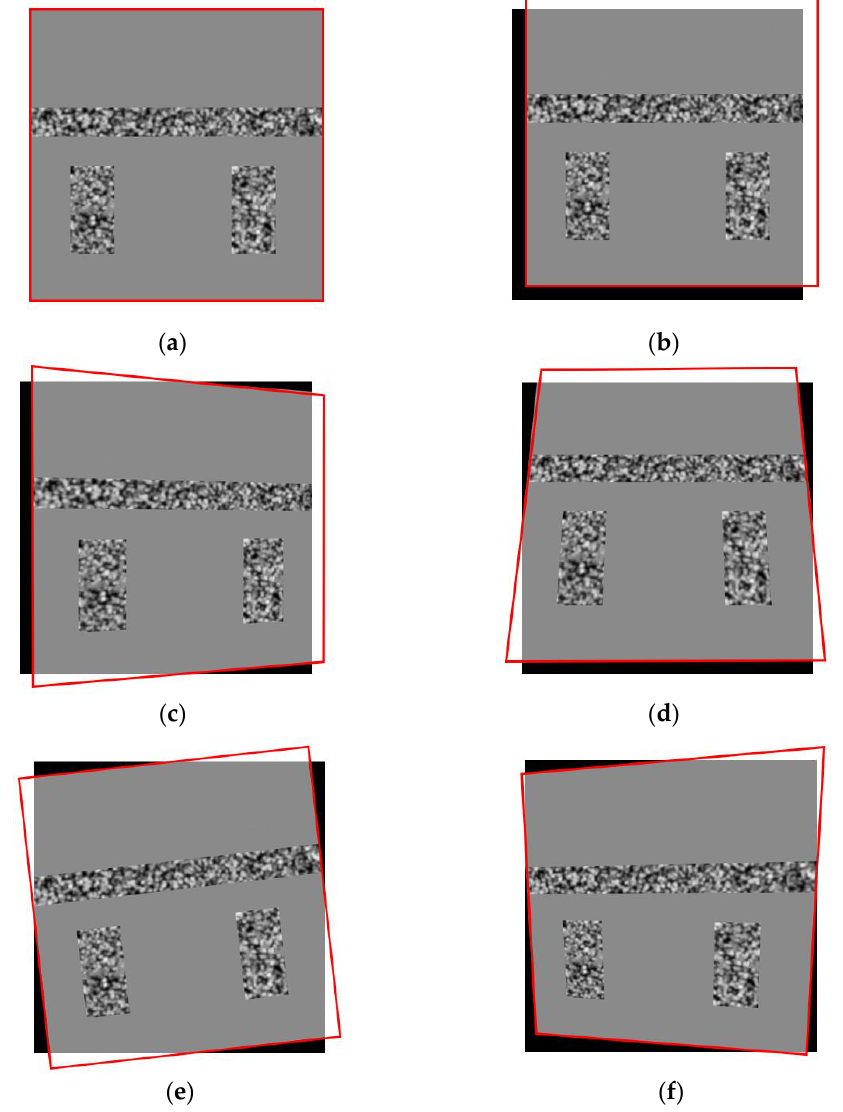
Figure 8. Camera wobble modes and corresponding image transformation: ( a ) still; ( b ) translation; ( c ) yaw; ( d ) pitch; ( e ) roll; ( f ) combination.